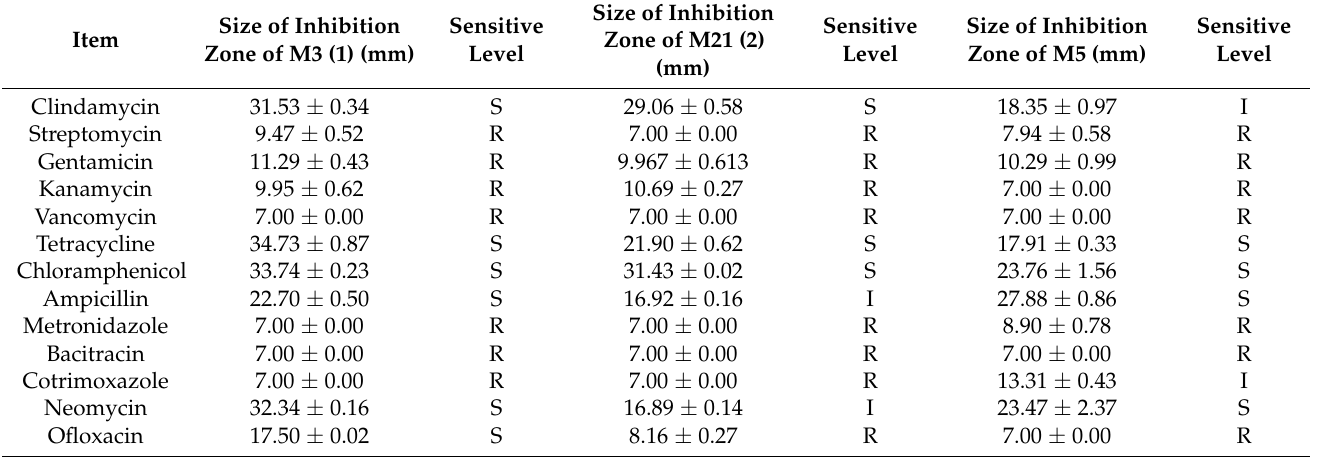
Table 8. Drug sensitivity test